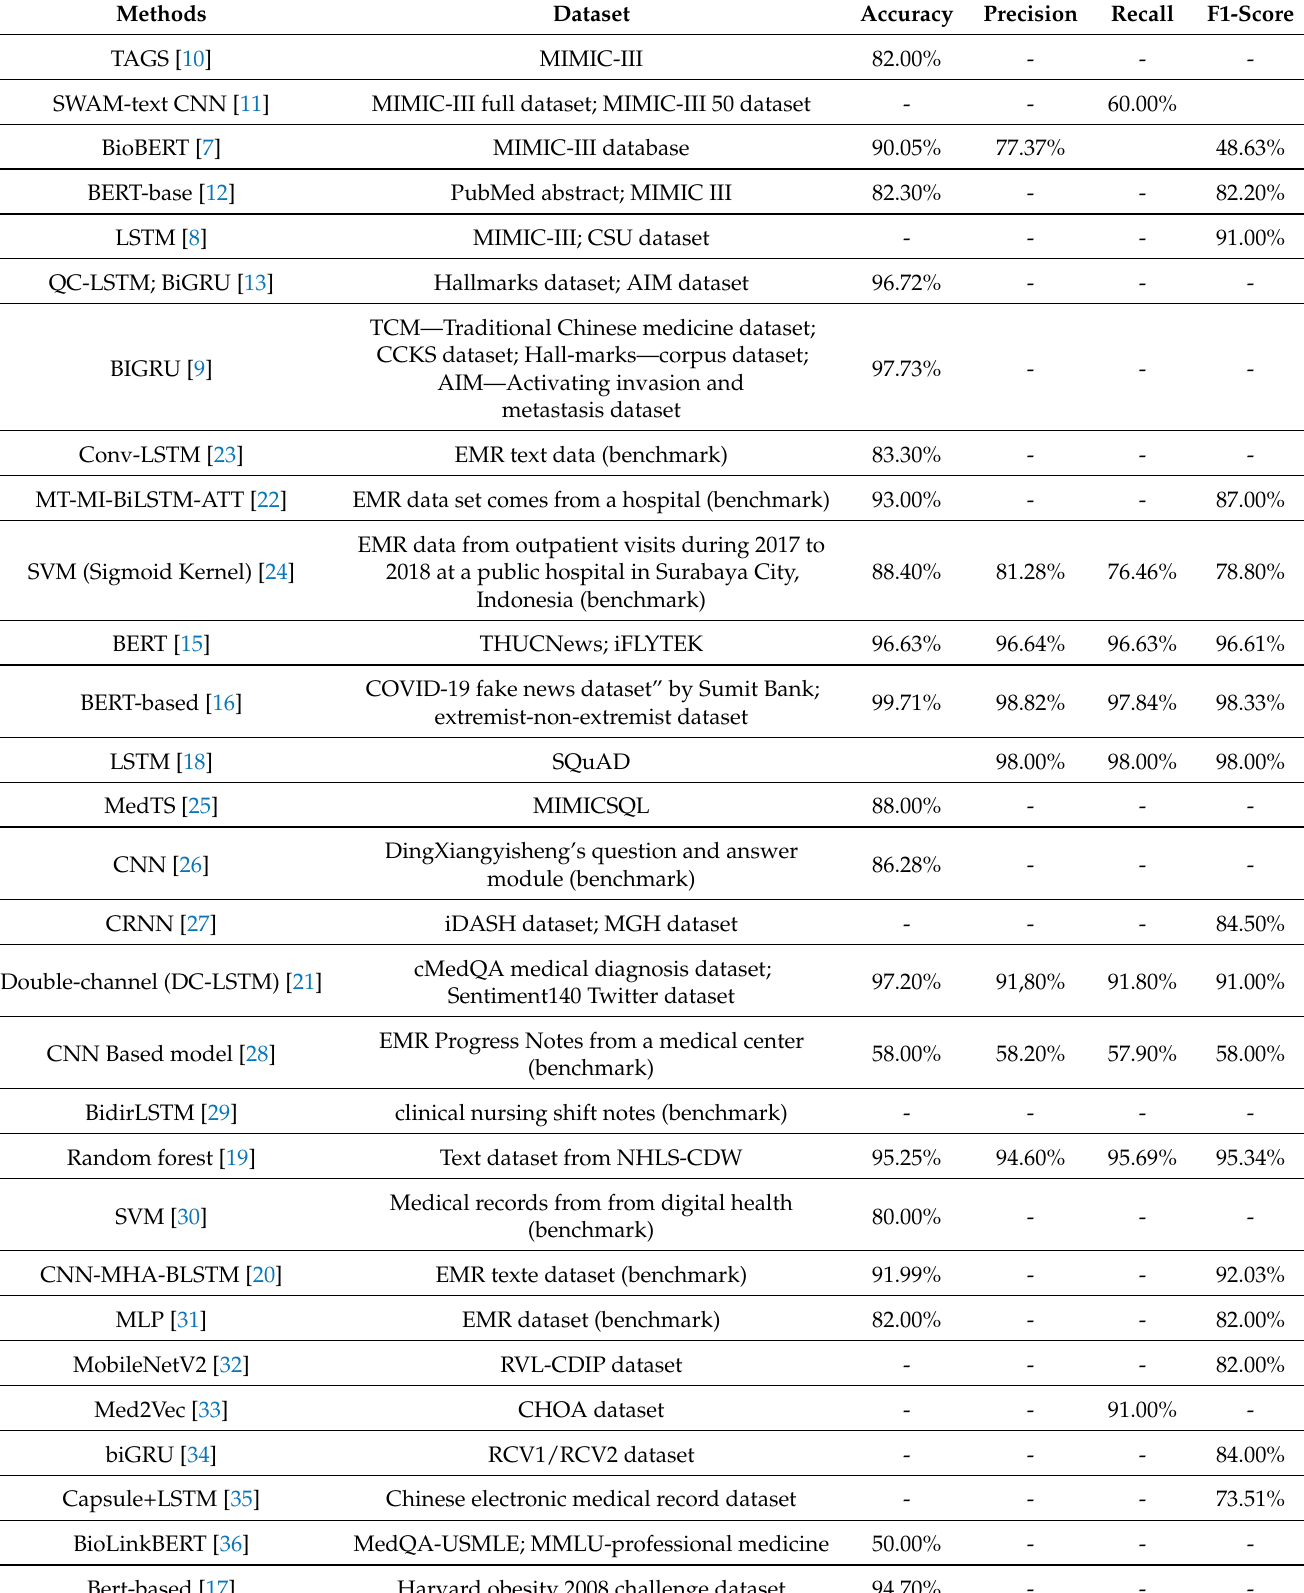
Table 6. Performance obtained on different text classification methods used in each